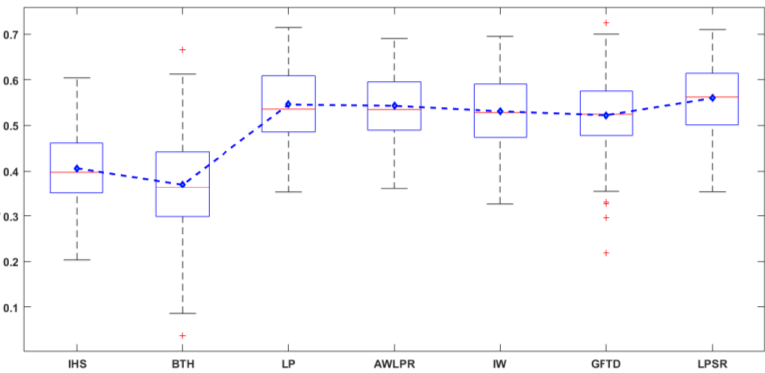
Figure 8. The box plot and mean values of the comprehensive index on a large set of images.